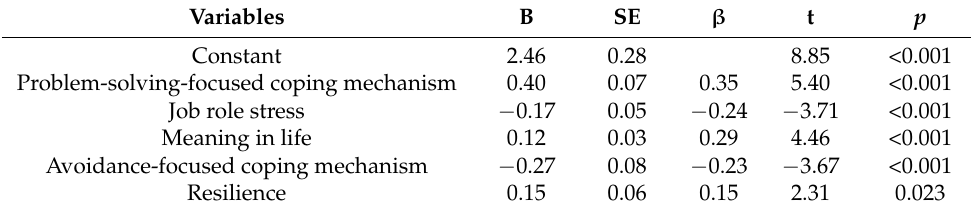
Table 4. Factors affecting the subjects’ psychological well-being. Variables B SE β t p Problem-solving-focused coping